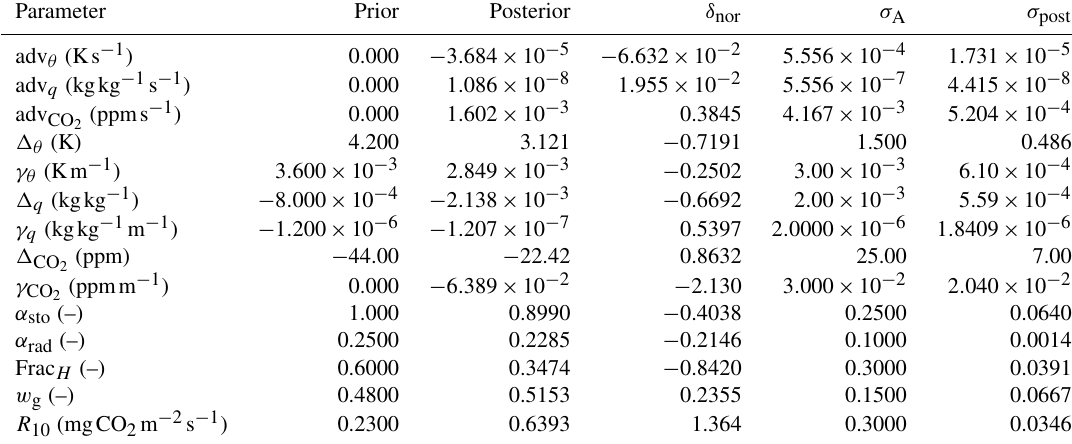
Table 7. State parameters for the Cabauw optimisation. δ nor is the normalised deviation, i.e. the posterior minus the prior, normalised with the square root of the prior variance (Eq. 24). σ A and σ post are, respectively, the prior and posterior standard deviation of the state